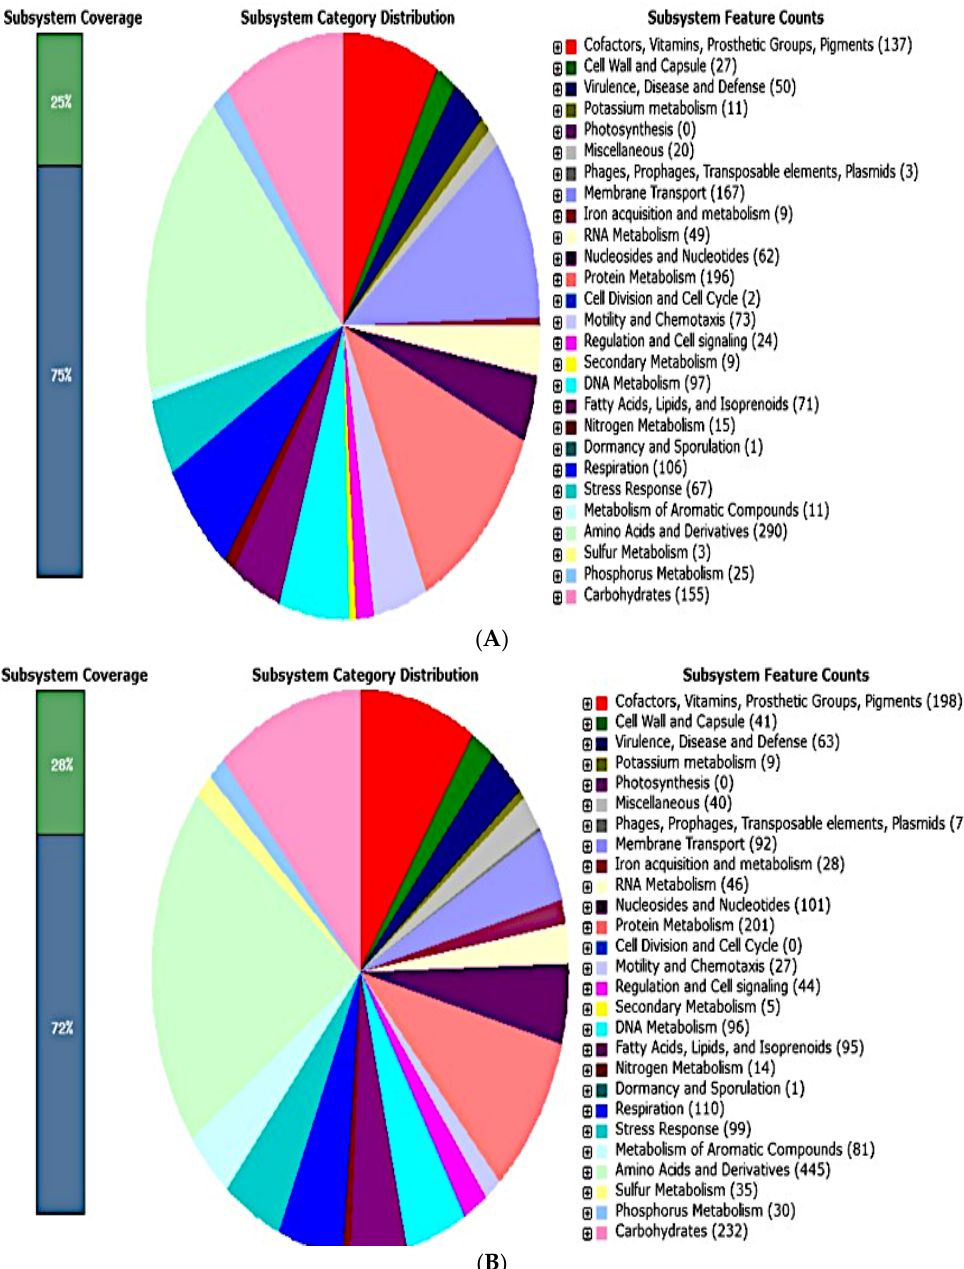
Figure 5. ( A ) Endophytic Stenotrophomonas geniculata strain NWUBe21 subsystem overview showing different functional/metabolic roles . ( B ) Endophytic Pseudomonas carnis strain NWUBe30 subsystem overview showing different functional/metabolic roles .